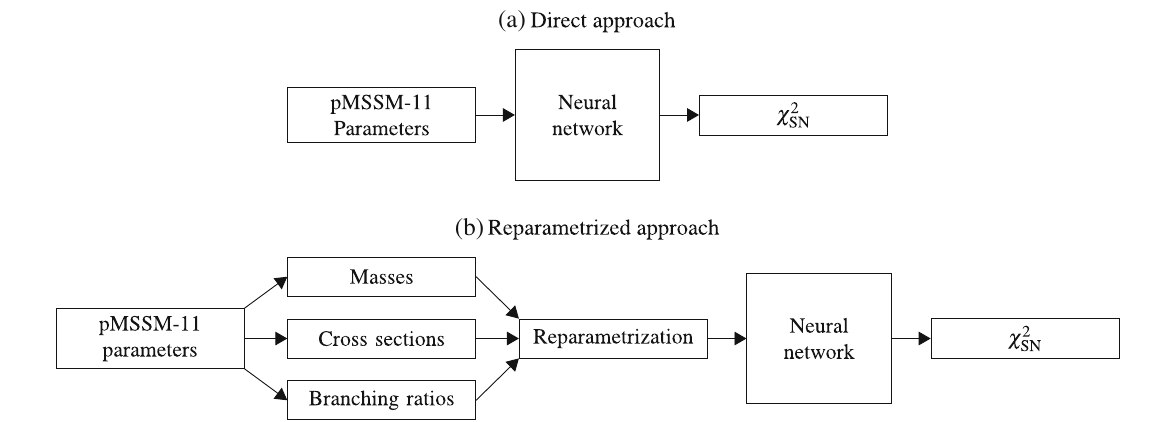
Fig. 1 Flowchart indicating how we have calculated the LHC χ 2 via the direct ( a ) and reparametrized ( b ) neural network regression approach described in the text. Throughout the paper, the subscript “SN” denotes χ 2 as obtained via